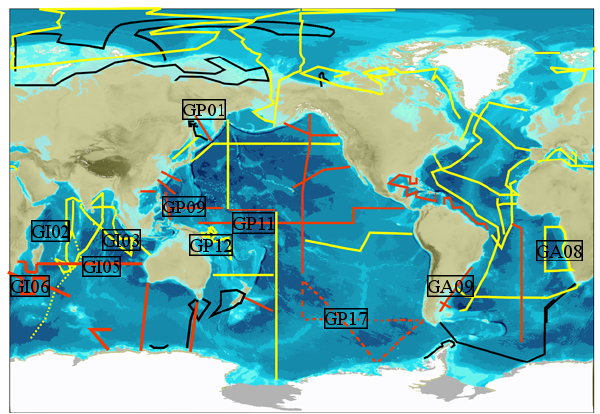
Figure 9. Map of GEOTRACES cruises (from http://www. geotraces.org/cruises/cruise-summary). Planned sections are in red, completed sections in yellow, International Polar Year sections in black. Names in rectangles correspond to cruises potentially bring- ing the largest extra information on 228 Ra fluxes because they are performed in places lacking